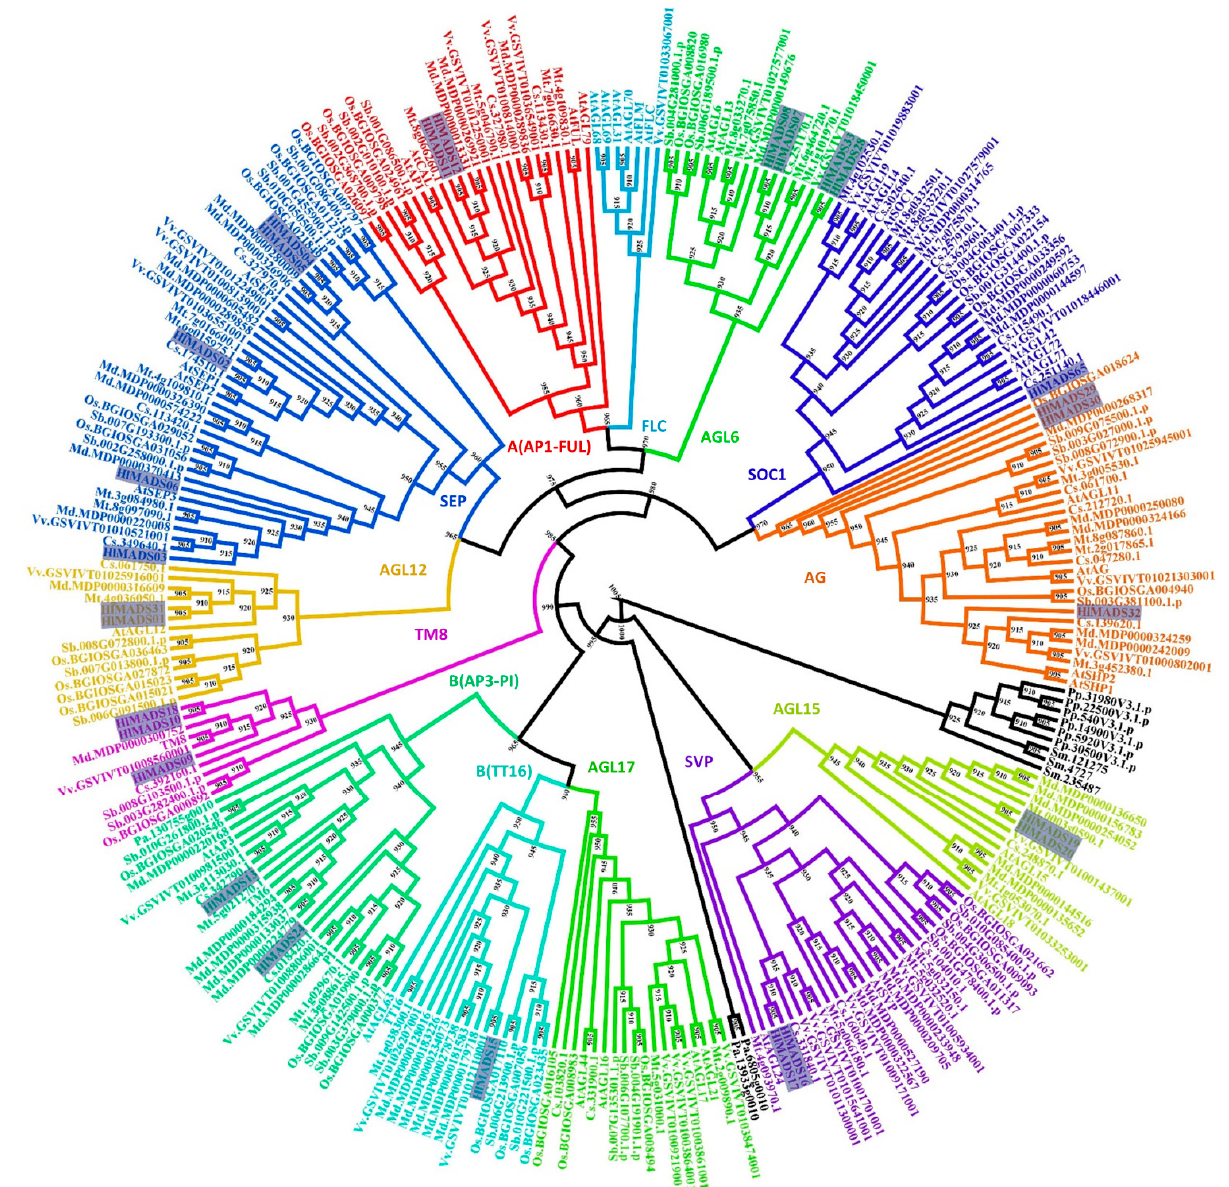
Figure 1. Phylogenetic tree of MIKC c -type MADS-box proteins of Humulus lupulus ((Hl) (27 sequences, highlighted)), Arabidopsis thaliana ((At)(39)), Solanum lycopersicum (TM6 and TM8), Physcomitrella patens ((Pp) (6)), Selaginella moellendorffii ((Sm) (3)), Piceaabies ((Pa) (3)), Sorghum bicolor ((Sb) (32)), Oryza sativa subsp. indica ((Os) (32)), Cucumis sativus ((Cs) (26)), Malus domestica ((Md) (42)), Medicago truncatula ((Mt) (35)), and Vitis vinifera ((Vv) (33)). Sequences from Selaginella moellendorffii, Physcomitrella patens , and Piceaabies were used as outgroups (in black font). For the type-I MADS-box proteins, the α -subfamily encompasses the most repre- sented group, with 26 members, followed by the β -subfamily (nine members). In con- trast, the γ -subfamily is represented by a single member (Figure 2).